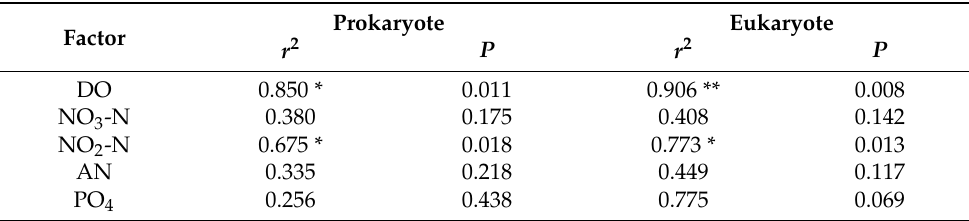
Table 3. The correlation coefficients between the microbial community structures and environmental factors and result of Monte Carlo permutation